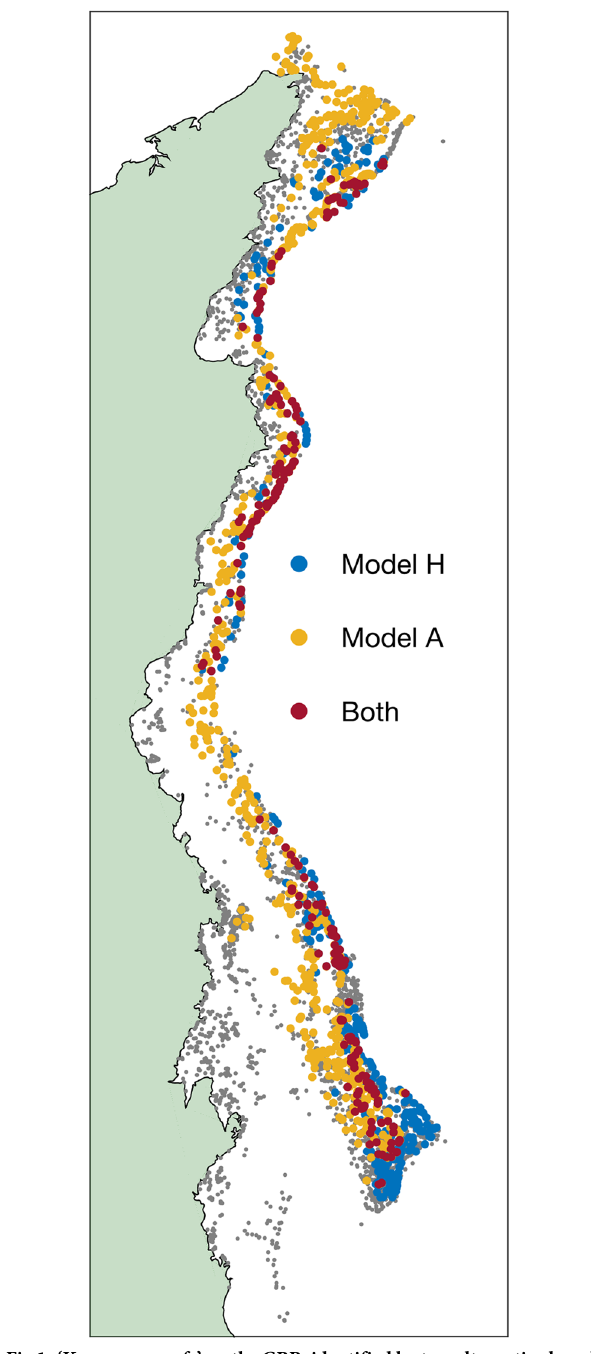
Fig 1. ‘Key source reefs’ on the GBR, identified by two alternative larval dispersal models. Reefs identified as key sources by Hock and colleagues. [2] (Model H) only are shown in blue. Reefs identified by the alternative model (Model A) only are shown in yellow. Key sources in both models are identified by red circles. The Australian coast is shown in green. GBR, Great Barrier